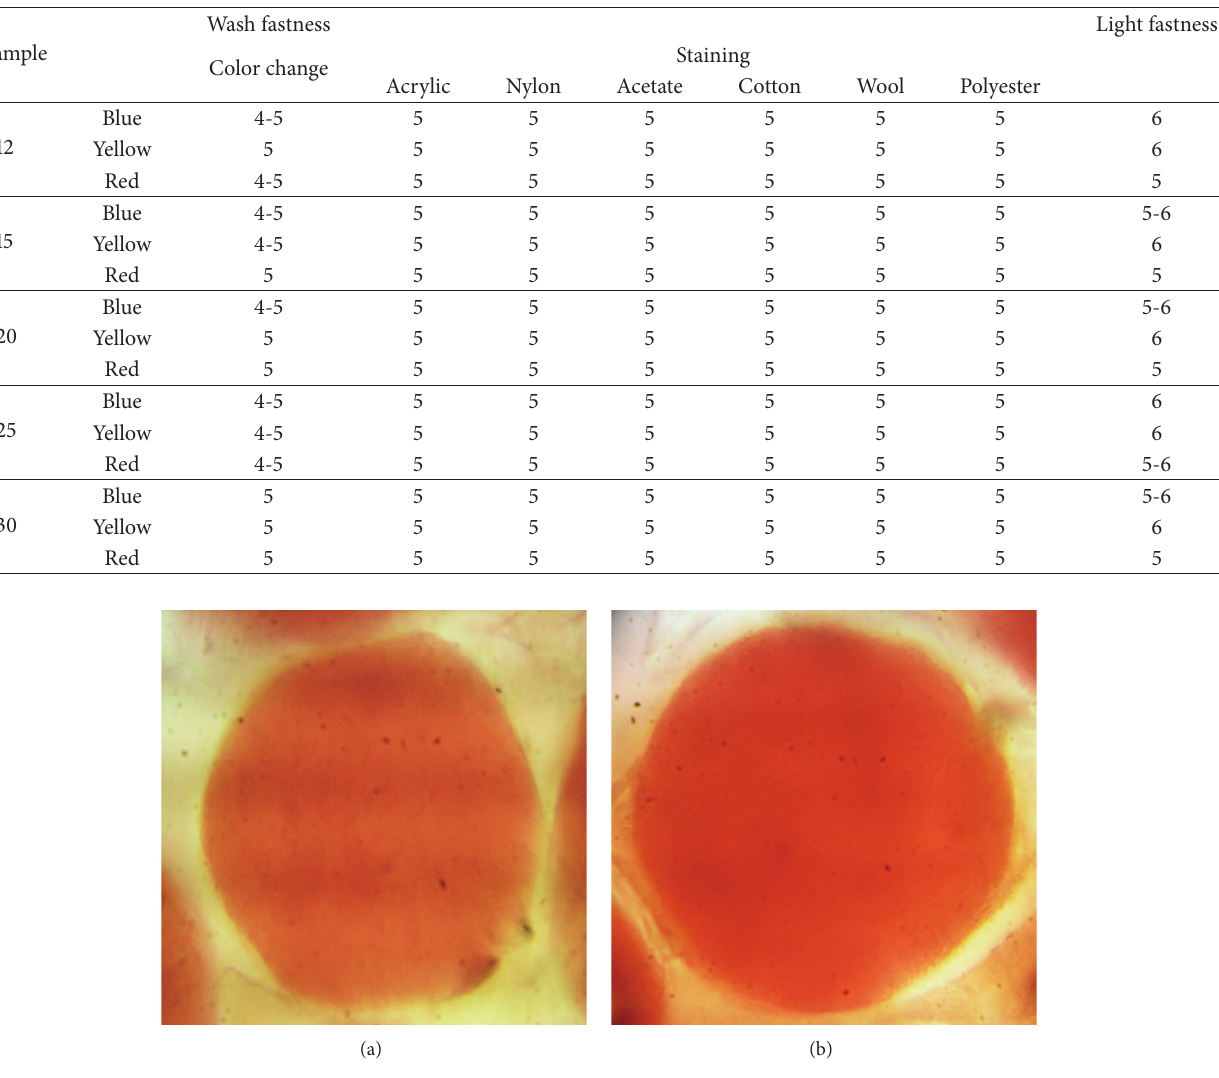
Figure 7: Polarized optical micro images of cross section of dyed B30 blend fiber at (a) 100 ∘ C; (b) 130 ∘ C.